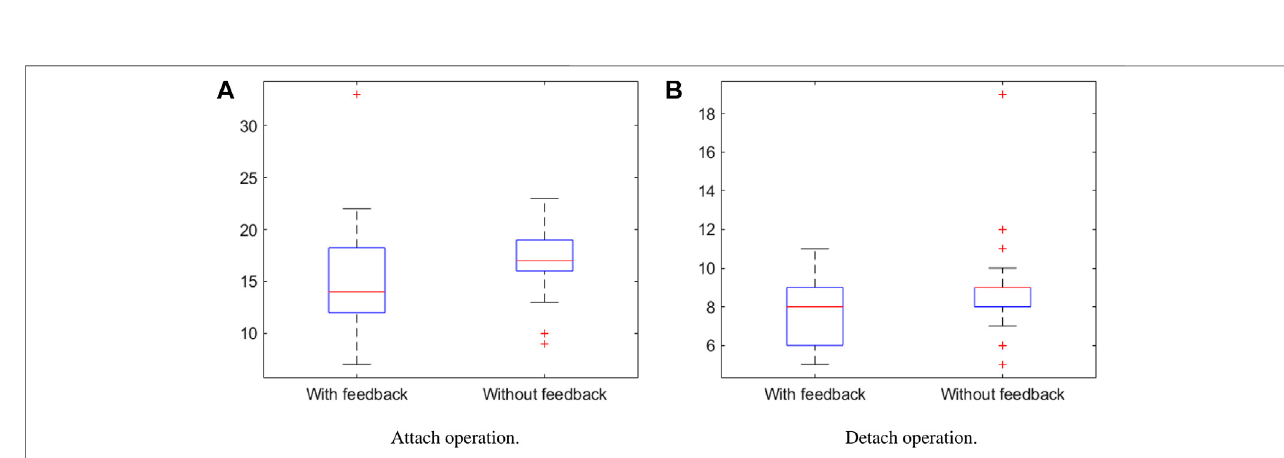
FIGURE 8 | Comparison of completion times with and without the use of tactile feedback. Boxplots of the completion time measured in the experimental trials for (A) attach operations and (B) detach operations.